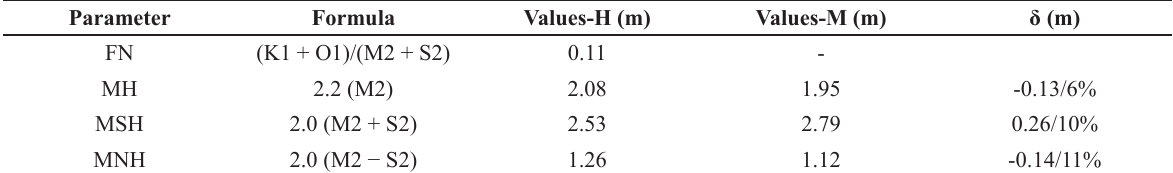
Descriptive tidal parameters derived from harmonic tidal constituents (Values-h) compared with the values derived from morphology (Values-M). FN: form number; Mh: mean tidal height; Msh: mean spring tide height; MNh: mean neap tide